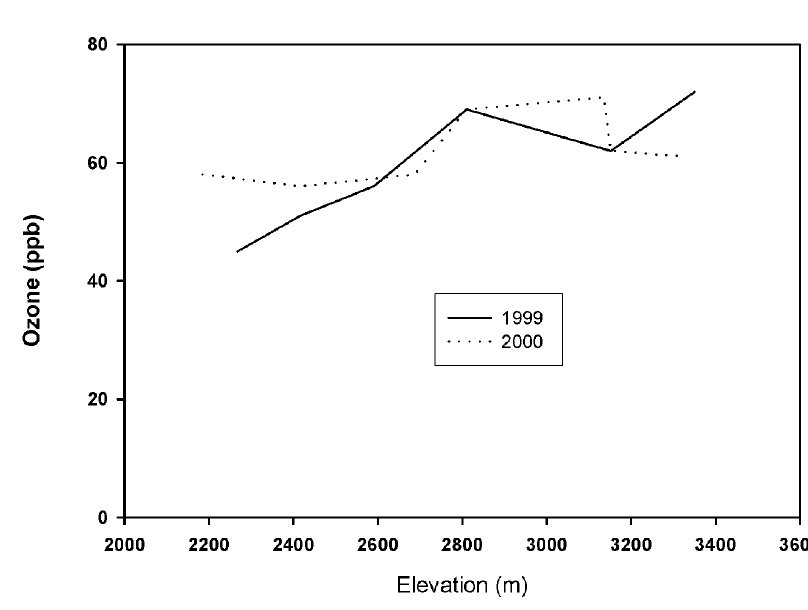
FIGURE 3 . Concentrations of O 3 determined with passive samplers on Mammoth